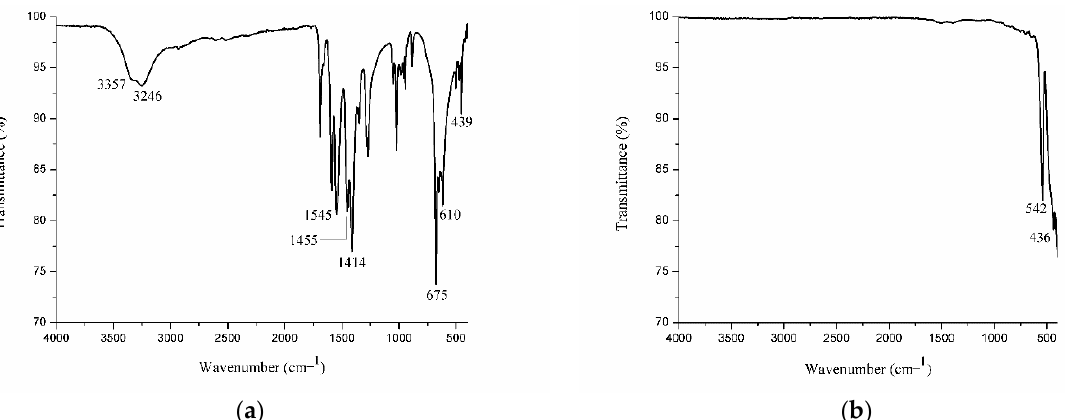
Figure 1. IR spectrum showing the characteristic absorption bands of the ( a ) precursor Gd(CH 3 COO) 3 ·6H 2 O salt and ( b ) Gd 2 O3:Eu 3+ nanoparticles synthesized from the salt and calcined at 1000 °C for 5 h.